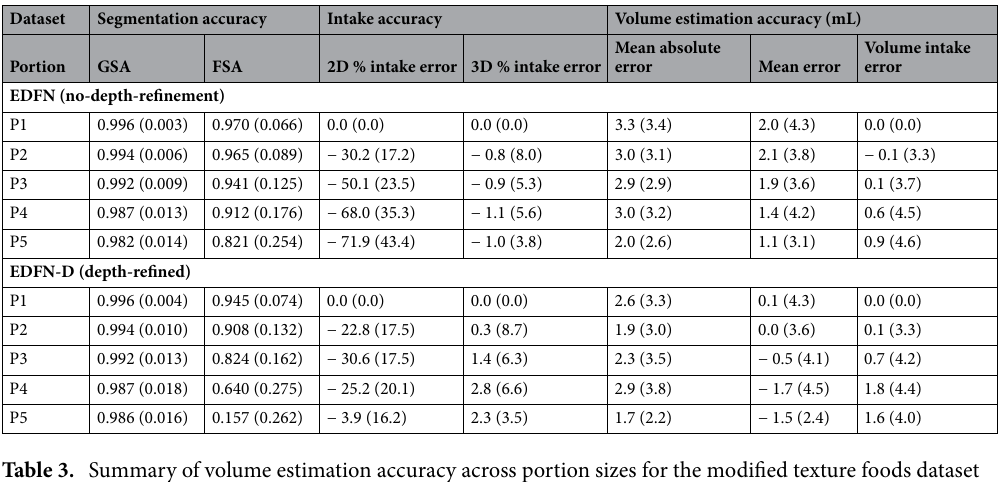
Table 3. Summary of volume estimation accuracy across portion sizes for the modified texture foods dataset across our proposed EDFN and EDFN-D. Values are (mean ± SD) GSA: Global segmentation accuracy, FSA: Food segmentation accuracy, IOU: intersection over